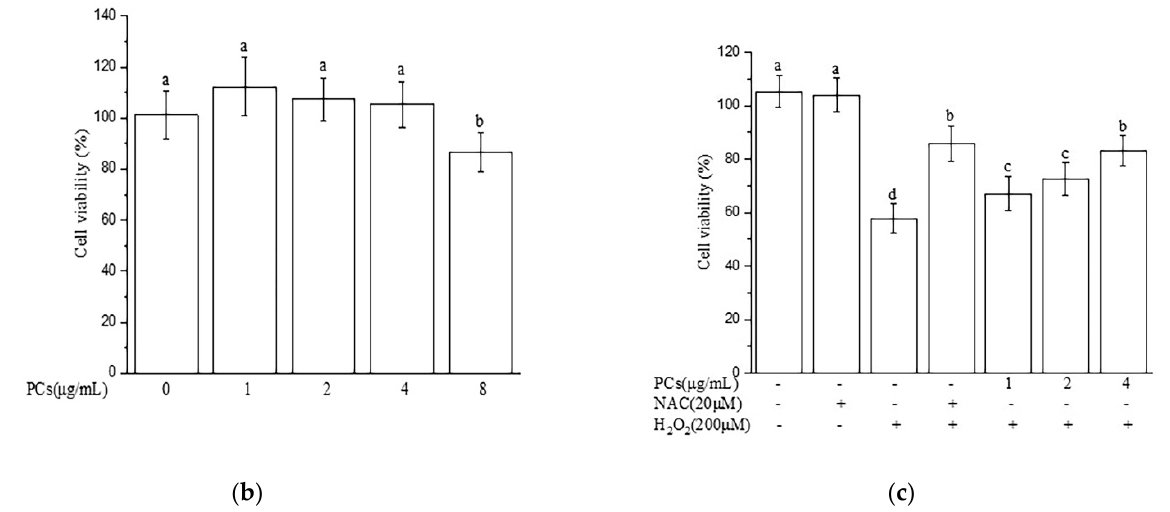
Figure 1. Effects of PCs on H 2 O 2 -treated cytotoxicity of PC12 cells. Cell viability was detected by CCK-8 assays. ( a ) Cytotoxic effects of H 2 O 2 at different concentrations in PC12 cells; ( b ) cytotoxic effects of PCs at different concentrations in PC12 cells; ( c ) PCs attenuated H 2 O 2 -induced decreases in cell viability. Data are expressed as the mean ± SD. All experiments were conducted six times. Values with different letters above each bar represent significant differences ( p < 0.05, one-way ANOVA).